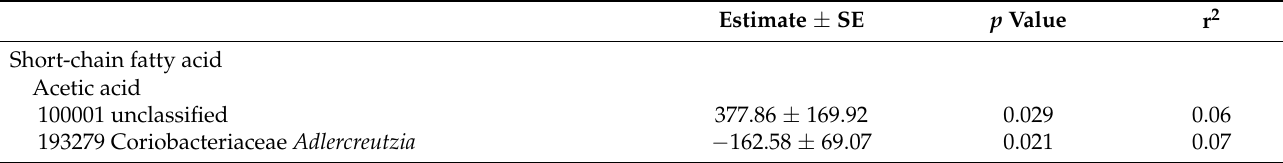
Table 10. Correlations between fecal short-chain fatty acids and